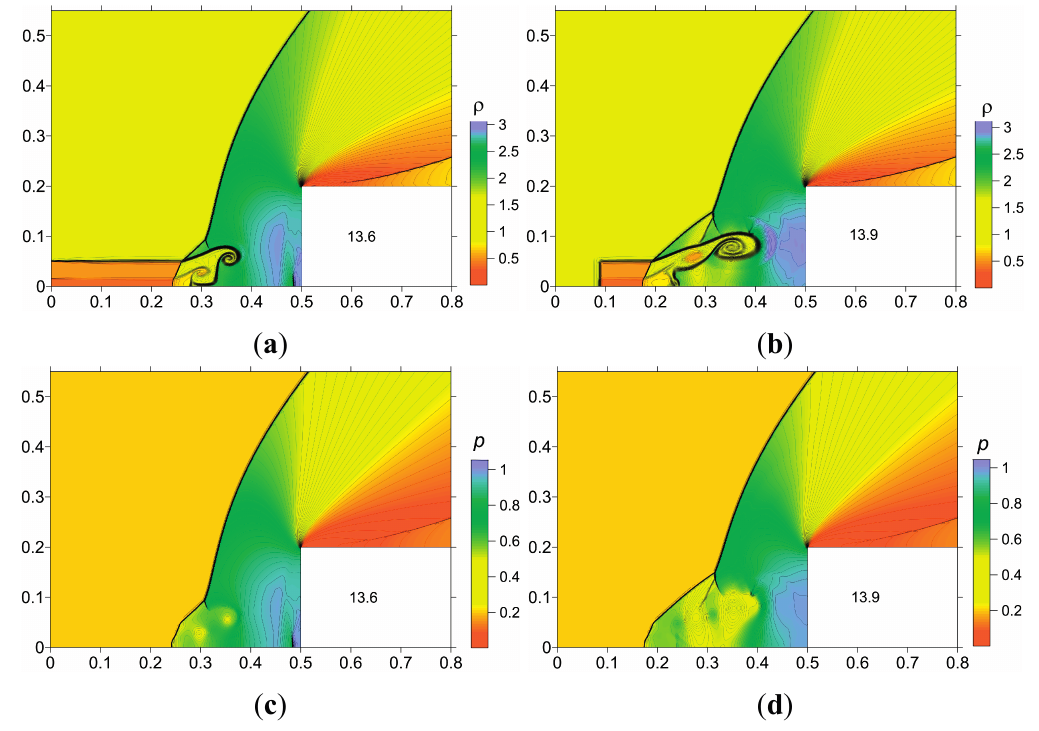
Figure 2. Generation of two vortices rotating clockwise as the result of the Richtmyer–Meshkov instabilities, d/D = 0.25, d 1 /D = 0.075, α ρ = 0.5, α ρ 1 = 0.35: ( a , b ) Density fields; ( c , d ) Pressure fields.